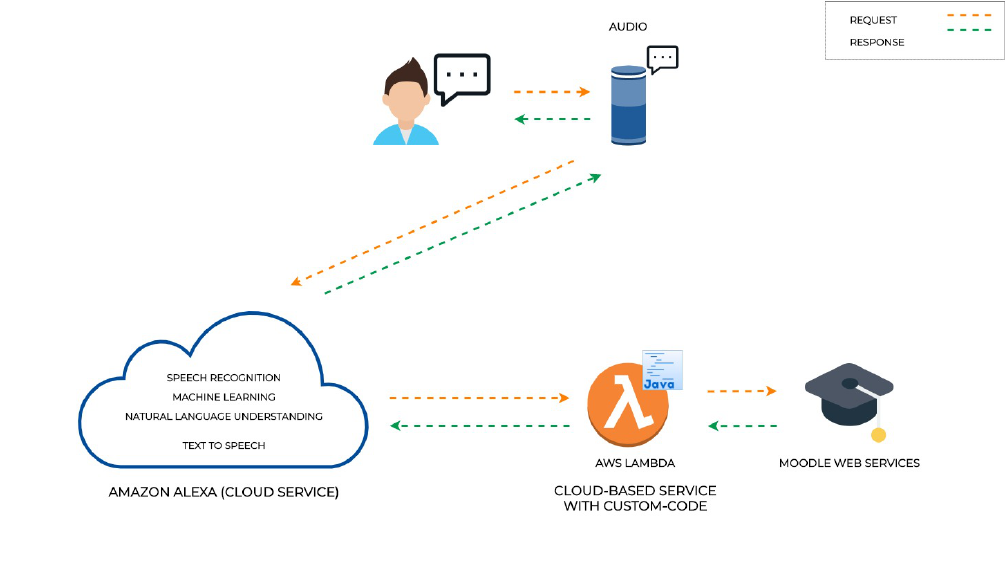
Figure 3. Diagram for processing a request by our custom Alexa skill (Source: own authors’